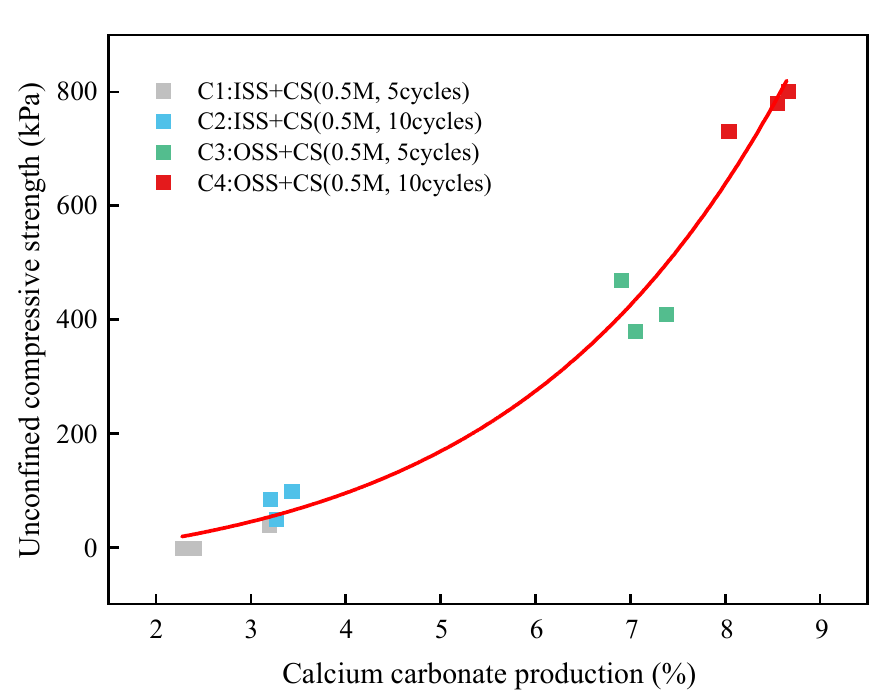
Figure 12. Stress ‒ strain curve of the treated samples. 3.5. SEM Test Results and Analysis Figure 13 shows the SEM test results of some samples before and after calcareous sand mineralization. Figure 13a shows the SEM image of the untreated calcareous sand; the surface of the calcareous sand is uneven and distributed with many pores, which re- flects the structure of the calcareous sand. Figure 13b shows the SEM image of calcareous sand in Group C2; the surfaces of the calcareous sand particles are covered by minerali- zation products filled with pores, and the particles are cemented with each other, which is the main reason for the increase in sample strength after mineralization. Figure 13c,d show the SEM test results of Groups C2 and C4 at higher magnifications, respectively. The morphology of the mineralization products differed between the two groups. Group C2 treated with the initial stimulation solution produced both needle-shaped and pyramid- shaped mineralization products, in which the needle-shaped crystals were increasingly smaller in size. However, the mineralization products of Group C4 treated with the opti- mal stimulation solution were all pyramid-shaped, and the crystal size was generally